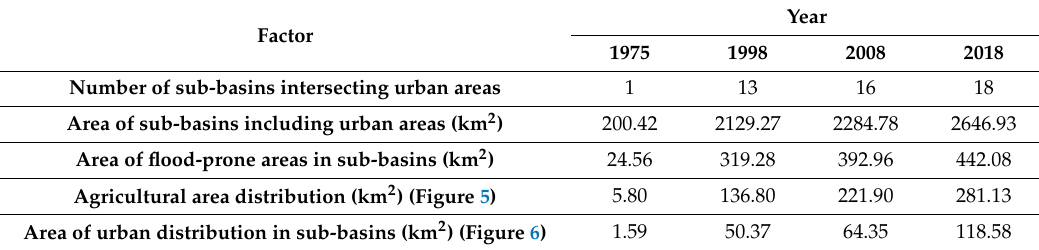
Figure 8. Urban and agricultural changes between 1975 and 2018 ( a – d ) in the Tabuk area, extracted from satellite images using Erdas Imagine and ArcGIS. Table 5. Urban and agriculture expansion in different time periods.